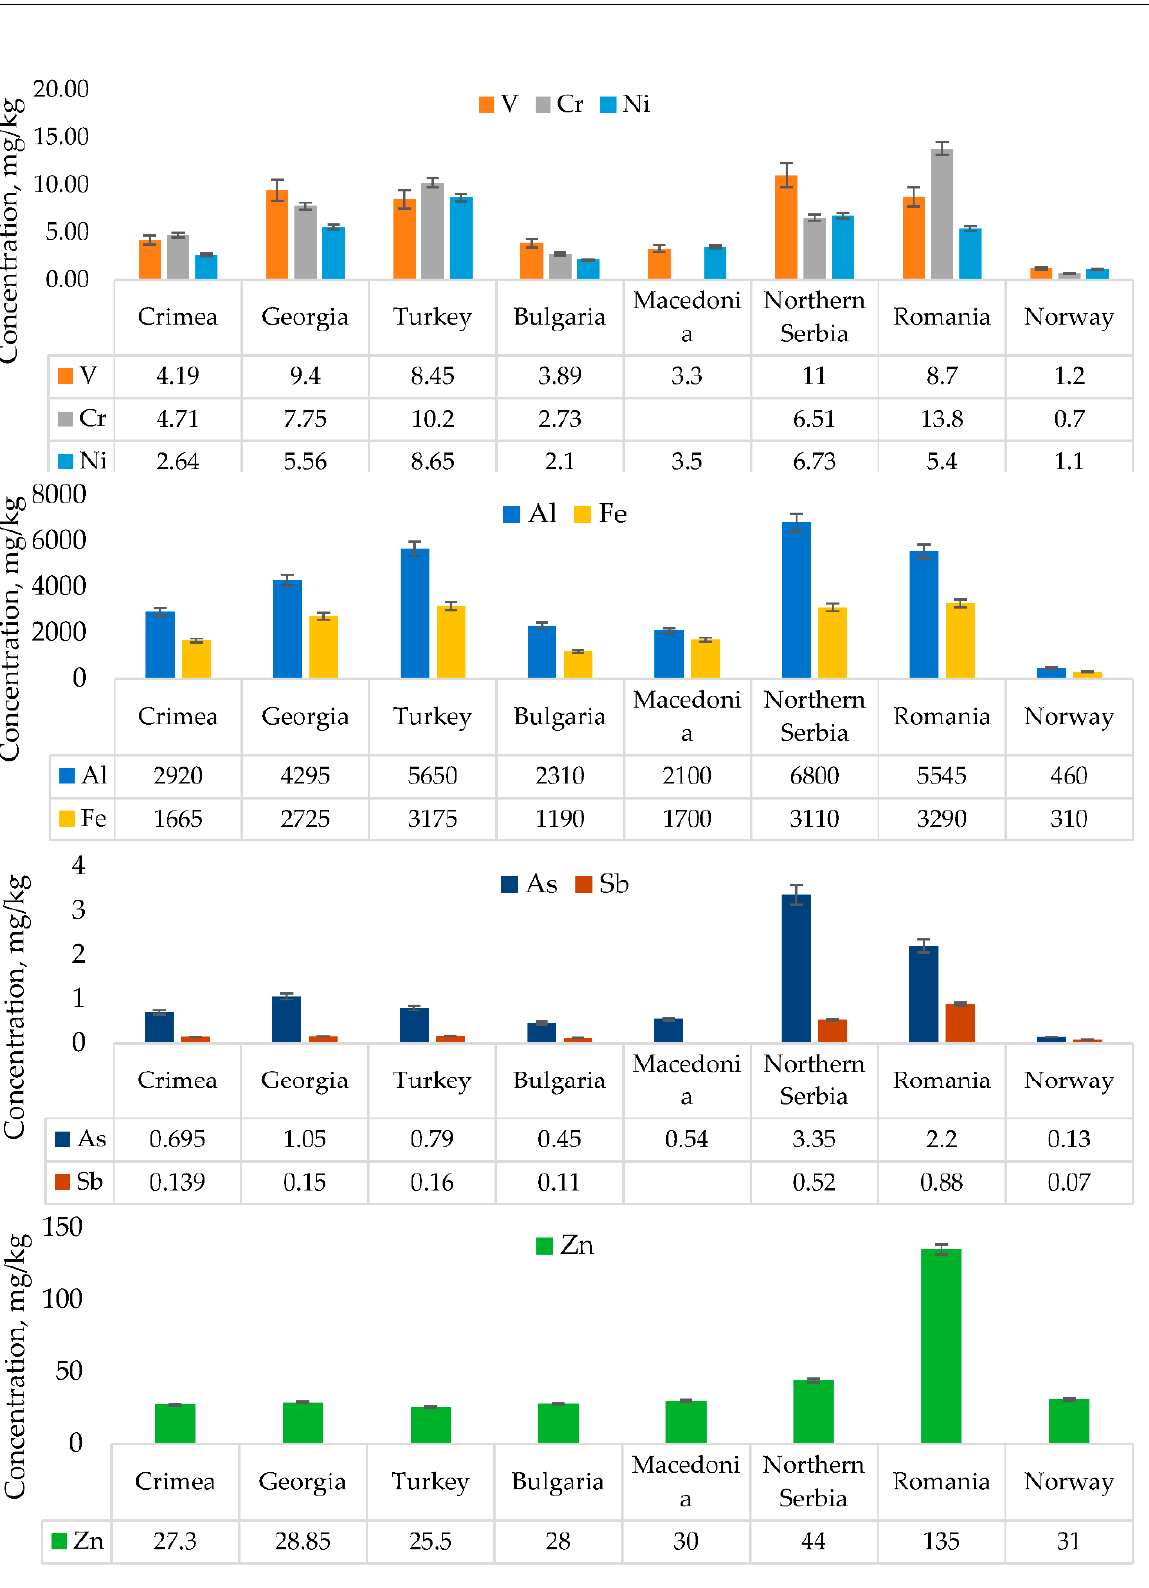
Northern Serbia and Romania. The levels of potential pollutants in Crimea were higher in comparison with Norway. According to the results of the factor analysis and compared